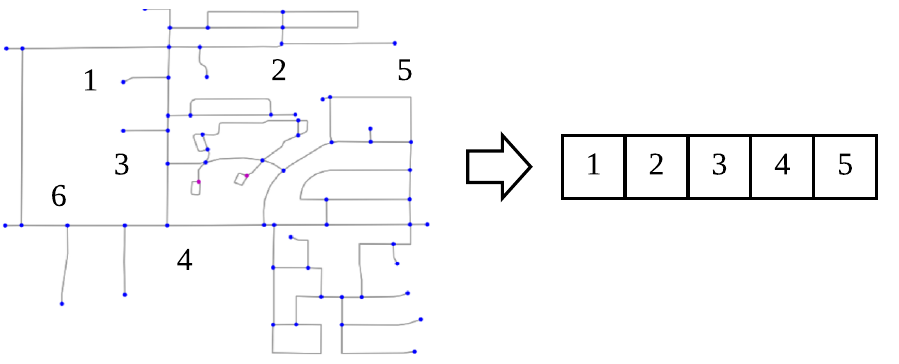
Figure 3. Example of a chromosome representing a possible solution. Street nodes are represented by IDs (numbers) and a solution is consisted of these IDs.